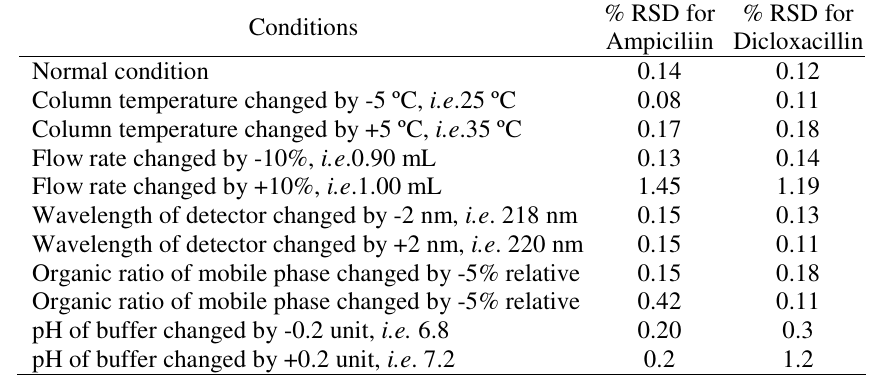
Table 8. Robustness study analysis for ampicillin and dicloxacillin capsules dosage